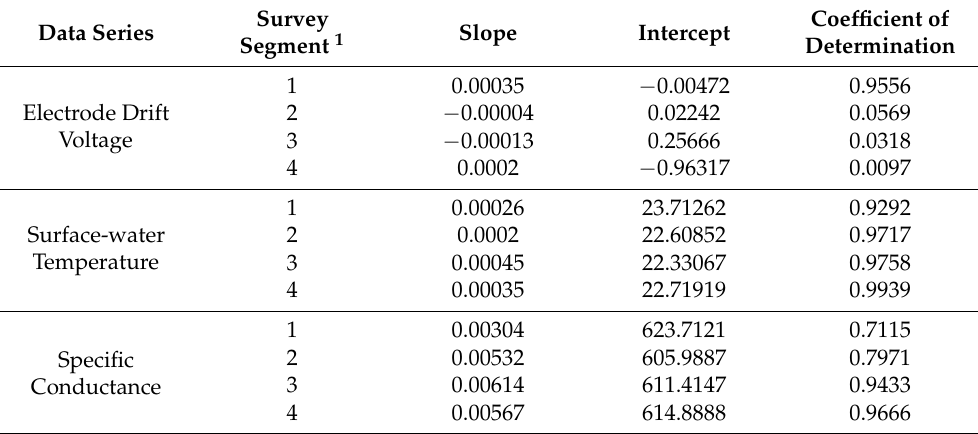
Table 1. Summary of slopes, intercepts, and coefficients of determination from ordinary least squares (OLS) regression lines fitted to the gradient SP data (electrode drift voltage), surface-water temperature, and specific